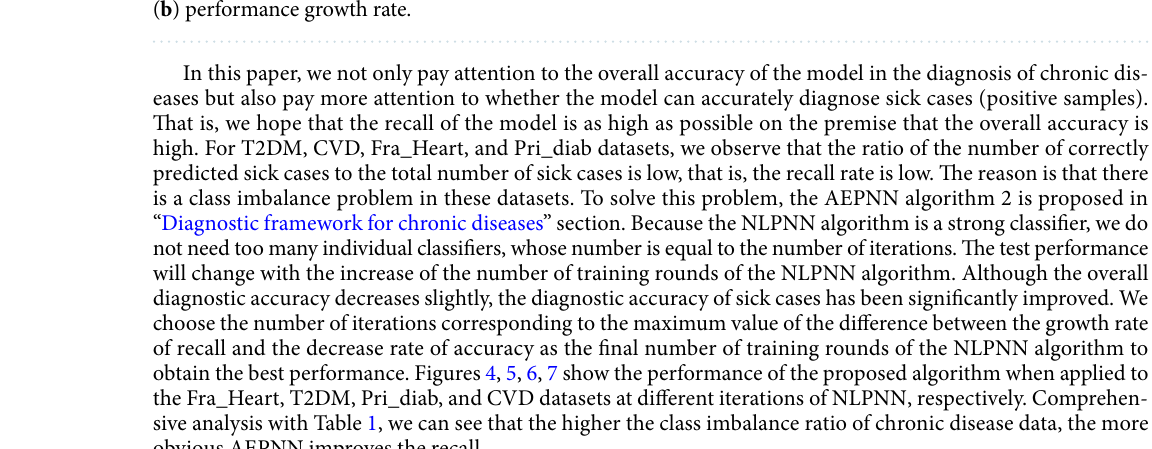
Figure 5. The test performance versus number of iteration on T2DM dataset: ( a ) generalization performance; ( b ) performance growth